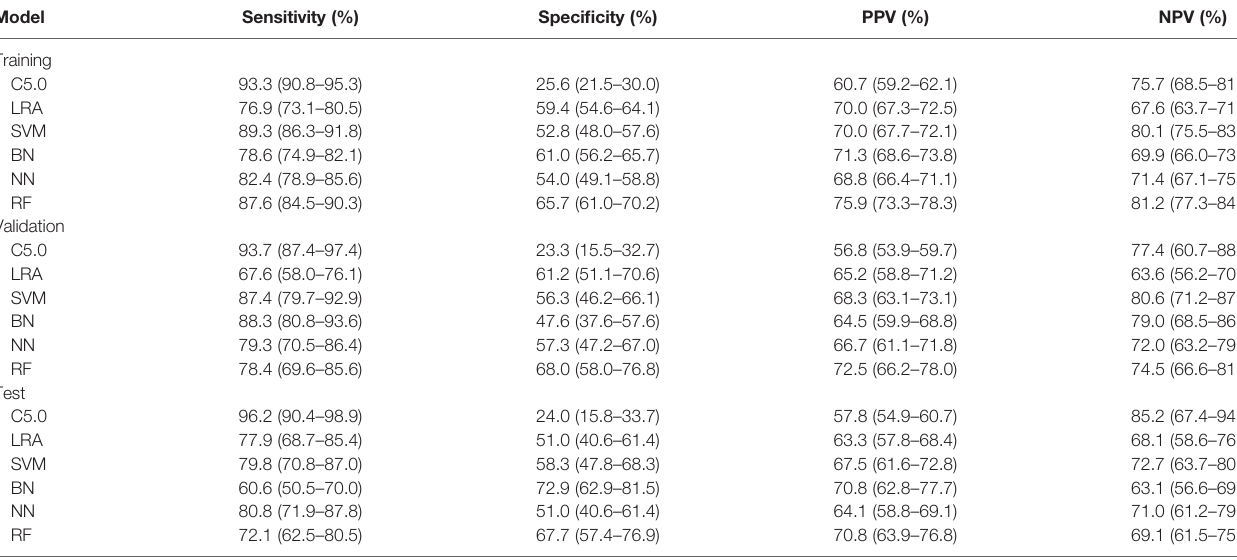
TABLE 3 | Comparison the performance of the six machine learning models for the training, validation, and test cohorts. Model